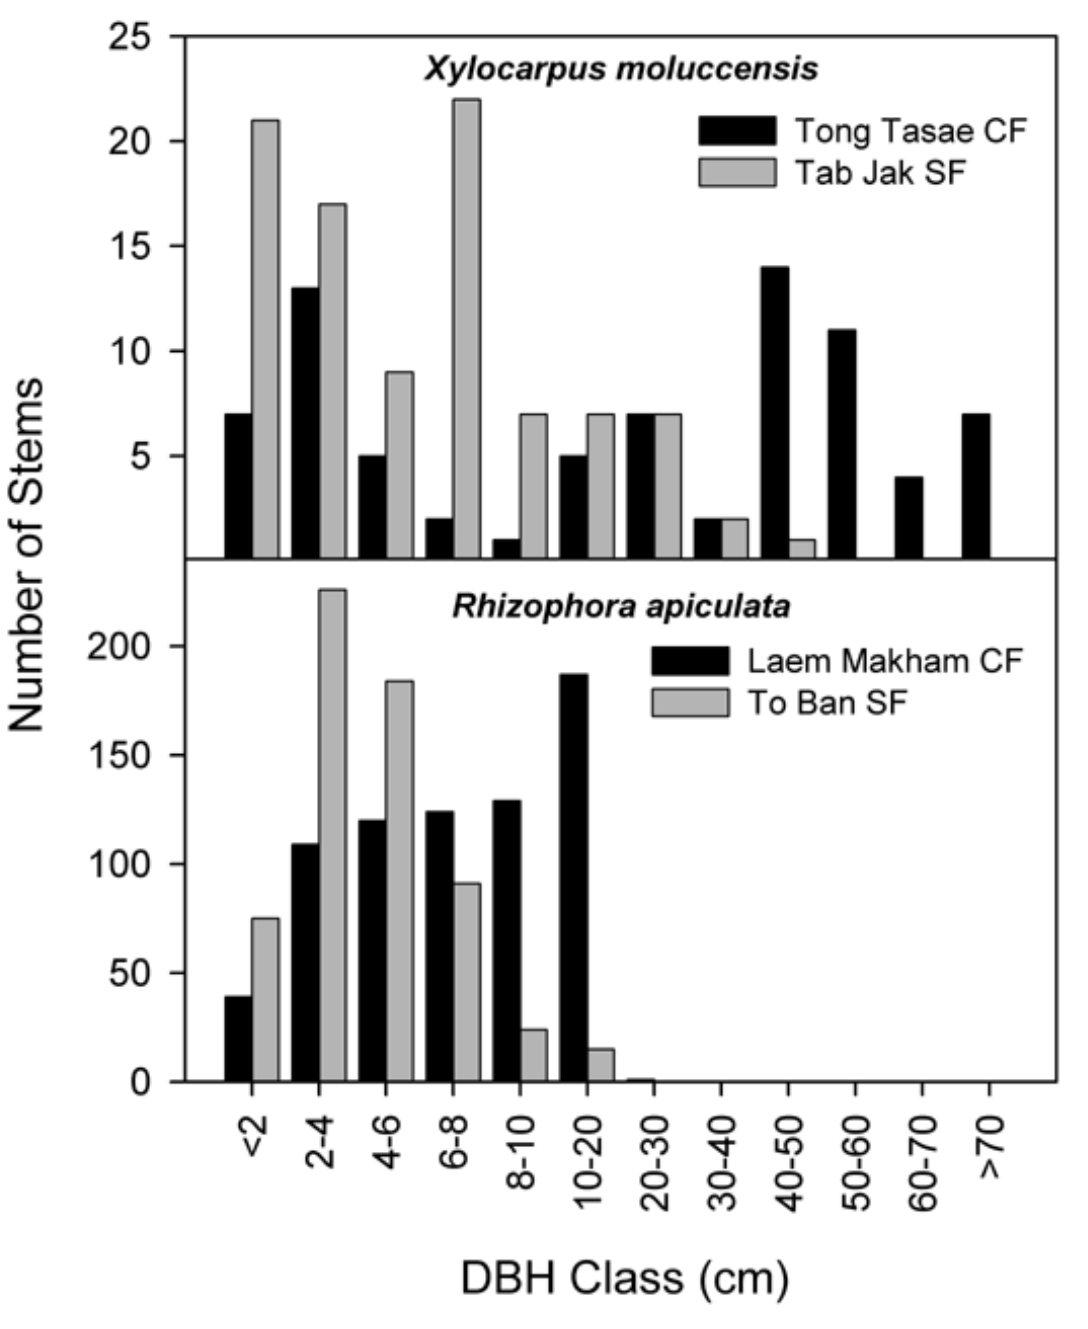
Fig. 3. The population diameter-at-breast-height (dbh) class distribution of important mangrove tree species in community- and state-managed mangrove forests in Trang, southern